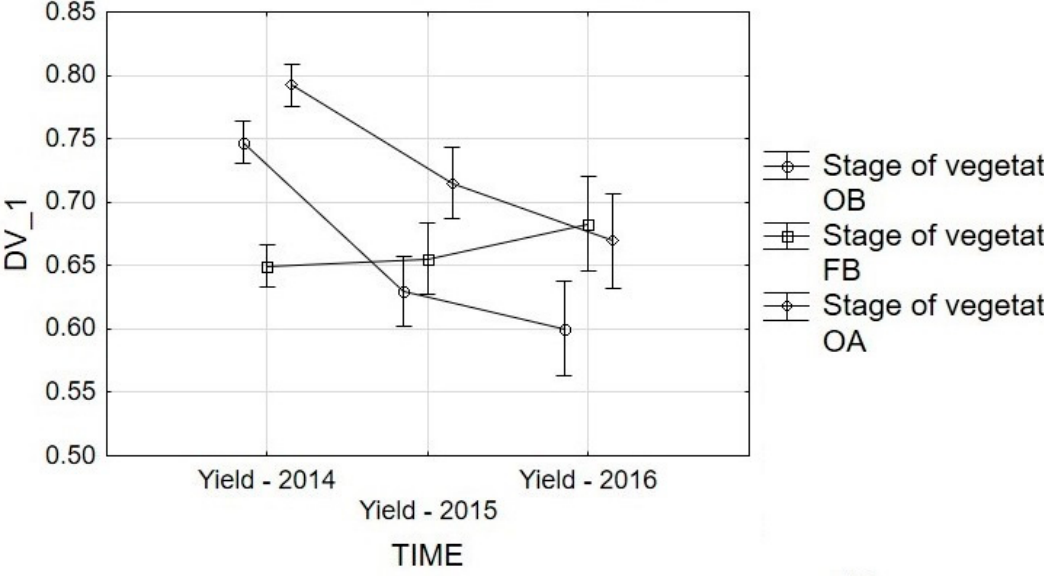
Figure 6. Repeated-measures ANOVA for Yield: interaction graphs for time and stage of vegetation. Vertical bars denote 0.95 confidence intervals. Estimated Marginal Means: TIME*Stage of vegetation. F(4, 270) = 11.057, p = 0.00. Stages of vegetation: OB, onset of budding; FB, full budding; OA, onset of anthesis.